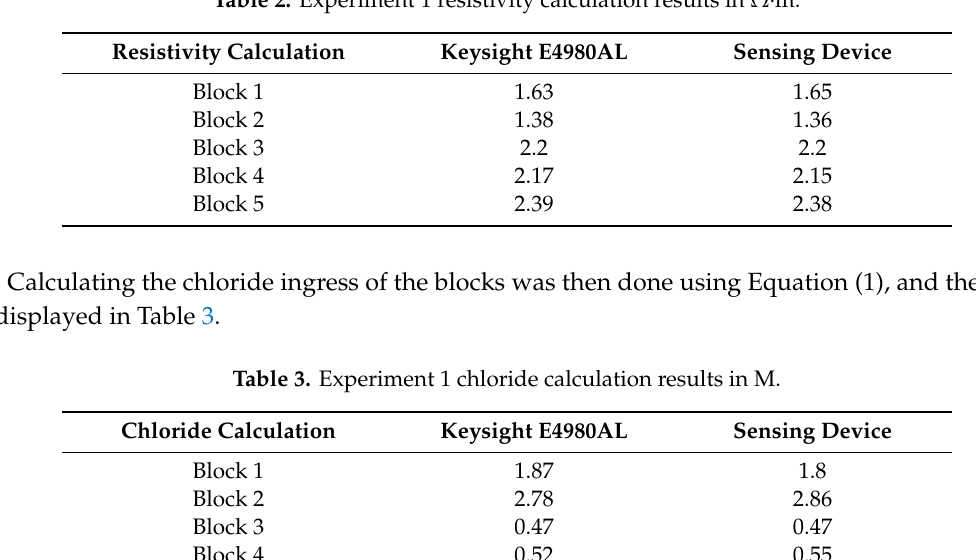
Table 2. Experiment 1 resistivity calculation results in Ω · m.